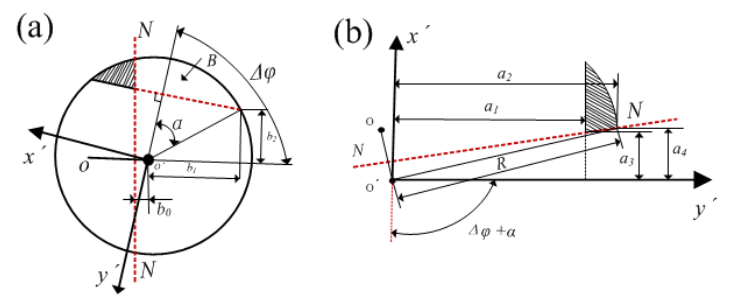
Figure 3. Schematic diagrams of the cross-section. ( a ) normal rotation position figure, ( b ) adjusted position figure for the convenience of calculation.